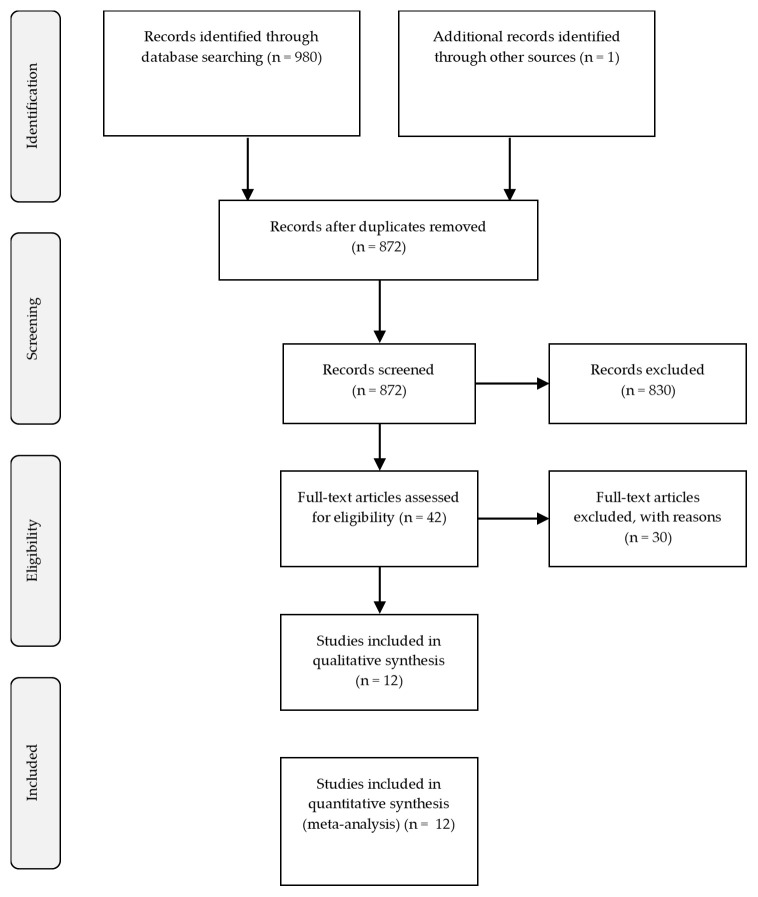
PRISMA flowchart.PRISMA, Preferred Reporting Items for Systematic Reviews and Meta-analyses.